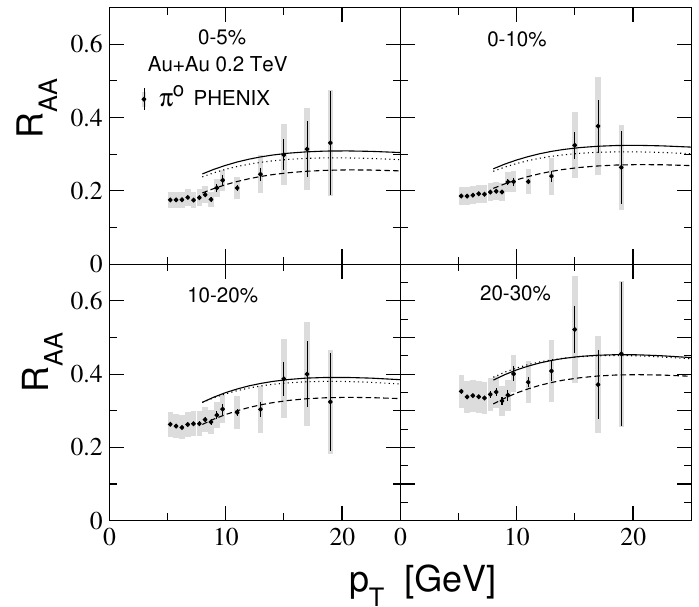
Figure 7 . Same as in figure 4 for R AA of π 0 in 0 . 2 TeV Au+Au collisions for the optimal parameters κ = 3 . 47 and 2 . 55 determined by fitting all the LHC data on R AA in Pb+Pb and Xe+Xe collisions. The dashed curves show the results for κ = 2 . 55 , corresponding to the mixed scenario with mQGP formation in pp collisions only at the LHC energies. Data points are from PHENIX